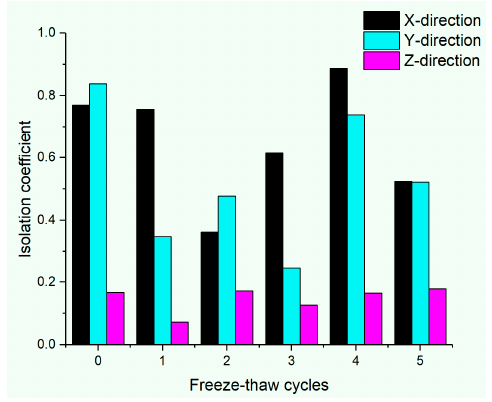
Figure 10. The isolation coefficient of the composite subgrade structure after freeze–thaw cycles.